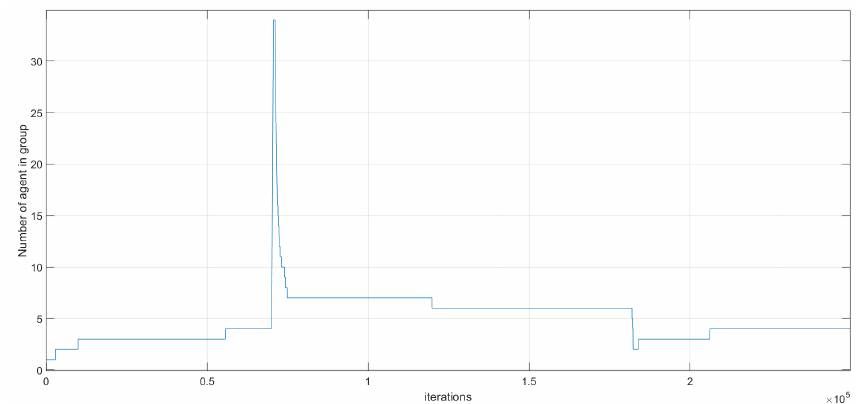
Figure 12. Adaptation of the group’s population in a space of 10 × 8 × 5 cells, simulated for 25,000 iterations: Pmax { f , k , v } = Pa { f , k , v } = Pr { f , k , v } = 400, TCa { f , k , v } = 0, TRa { f , k , v } = 280,